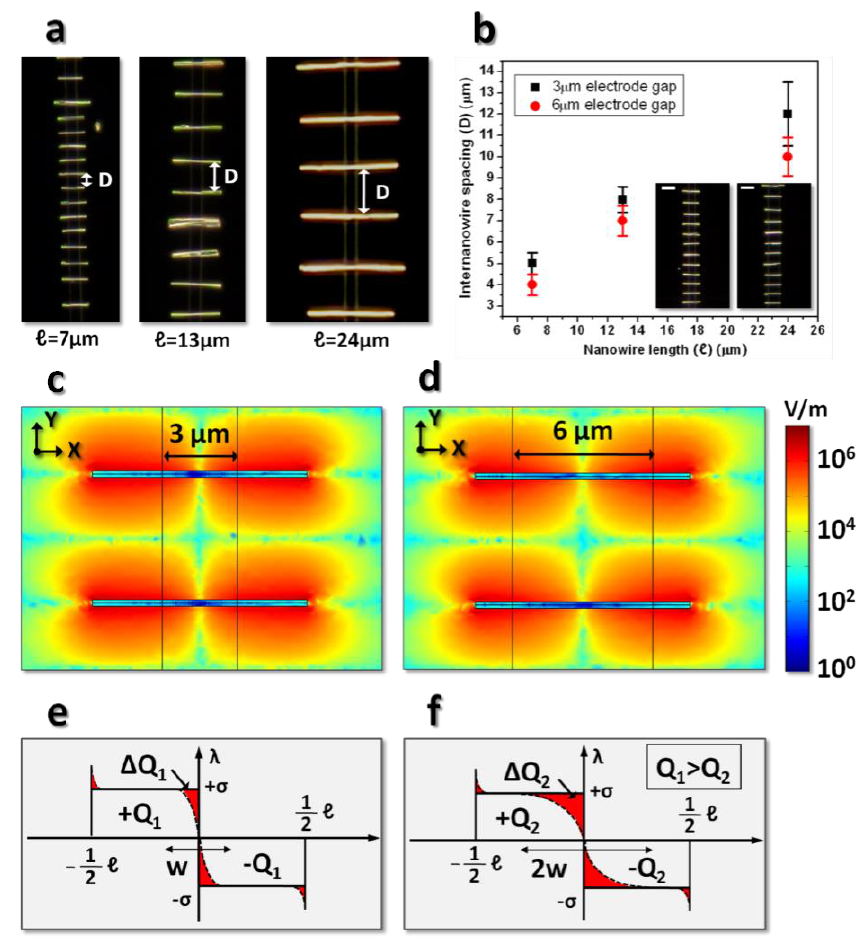
Figure 3. Inter-nanowire spacing as a function of the nanowire length and electrode gap width. ( a ) Representative dark-field optical microscope images of an array with different nanowire lengths (ℓ = 7, 13, and 24 μm), also indicating the different inter-nanowire spacing, proportional to their lengths. ( b ) Plot for the inter-nanowire distance with different nanowire lengths (ℓ = 7, 13, and 24 μm) where different widths of electrode gaps, 3 μm (black square) and 6 μm (red circle), are employed. This plot shows that the nanowires tend to be less spaced with wider electrode gaps, while forming the ordered array. The inset exhibits a 7 μm long rhodium nanowire array with 3 μm (left) and 6 μm (right) electrode gaps. The simulation of a y-component electric field, E y , on the nanowires assembled with ( c ) 3 μm and ( d ) 6 μm wide electrode gaps. Schematic drawing of the charge density along a nanowire’s length, highlighting the effect of ( e ) 3 μm and ( f ) 6 μm wide electrode gaps. Noticeably, the central part of nanowires’ overlapping the electrode gap will induce a lower charge density ( λ ) and the electric field (E y ) of the nanowires, eventually affecting the nanowires’